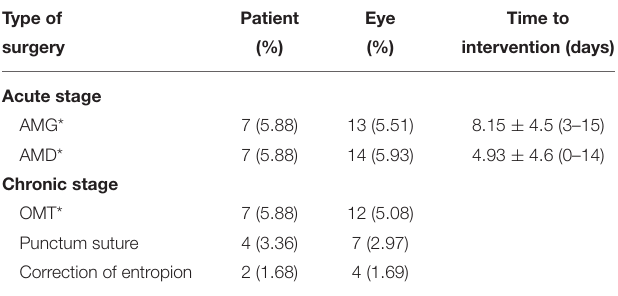
TABLE 5A | Surgical intervention in the acute and the chronic stage of SJS/TEN.